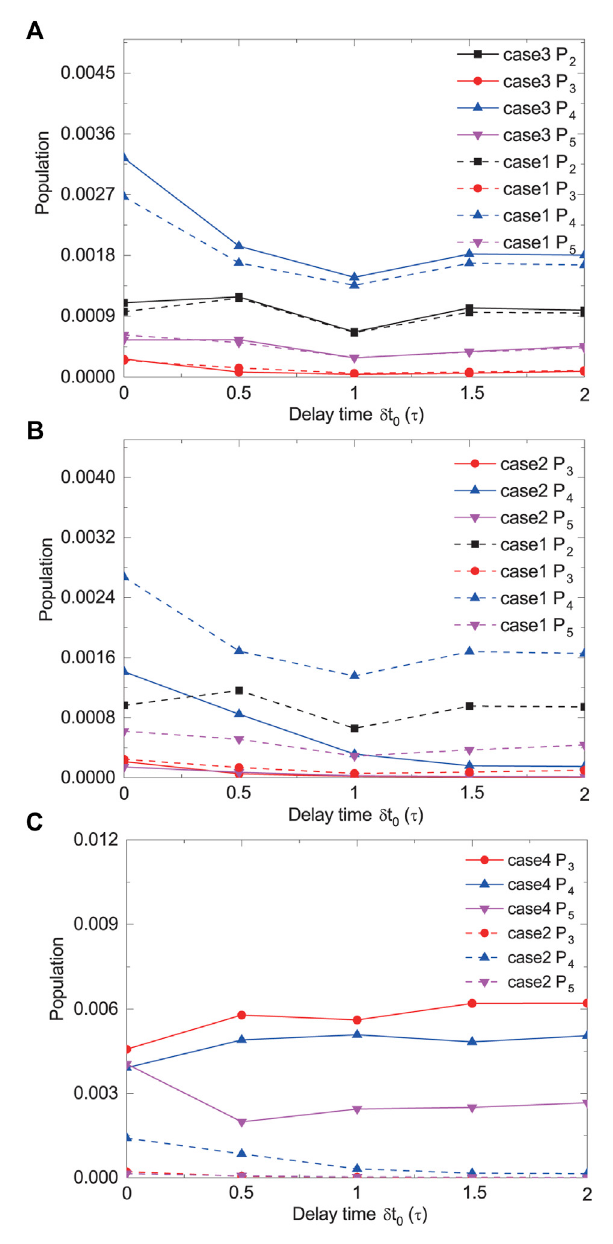
FIGURE 5 The comparisons of the fi nal populations of the four excited states vary with δ t 0 between (A) Case 1 and Case 3, (B) Case 1 and Case 2, (C) Case 2 and Case 4. Here, τ = 100 fs.